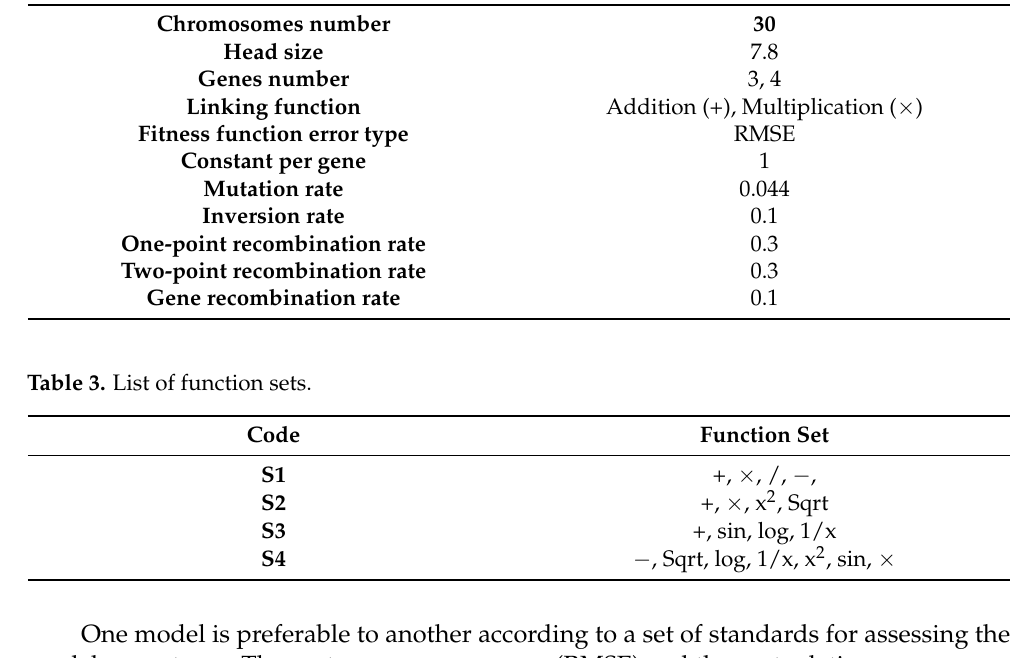
Table 2. GEP model parameters.